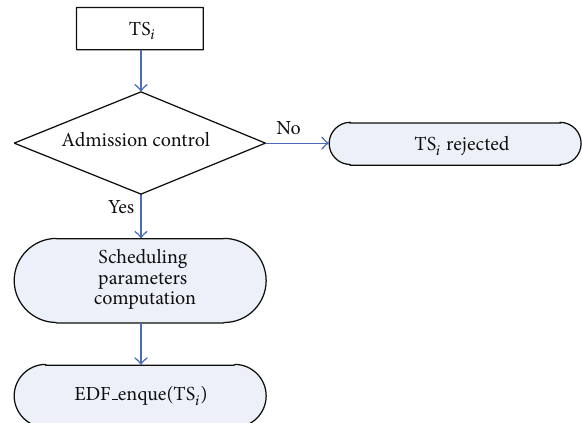
Figure 1: Admission control test and activity of a centralized scheduler.